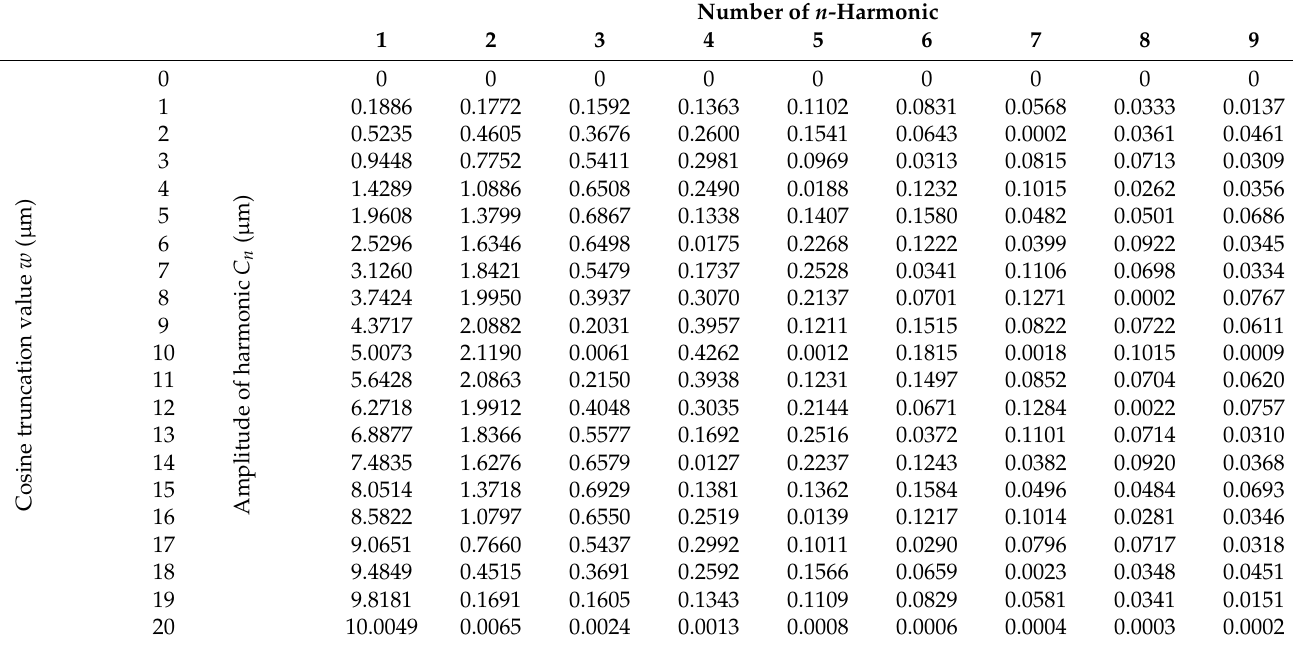
Figure 4. Variation of the amplitudes of the first nine harmonics as a function of the ‘truncations’ every 1 µm of a full cosine with an amplitude of 10 µm. Table 1. Variation of the amplitudes of the first nine harmonics depending on the ‘truncations’ every 1 µm of a full cosine with an amplitude equal to 10 µm.